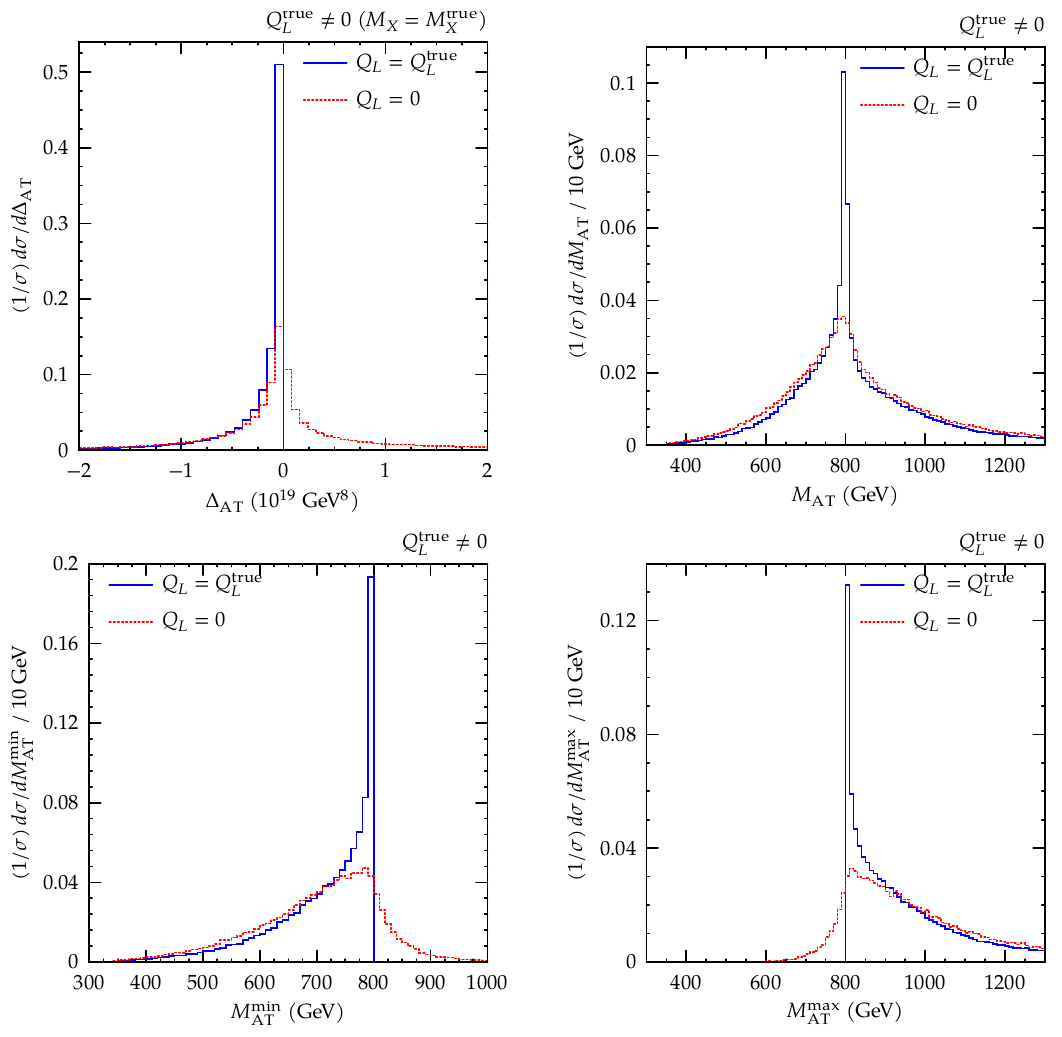
Figure 3 . The (cid:1) AT and M AT distributions in the presence of longitudinal boost of the resonance. In each panel, the blue distribution is obtained by assuming that the longitudinal momentum Q L is known, while the red one is by setting Q L = 0 when computing the variables. The latter corresponds to (cid:1) (0) or M (0) AT AT